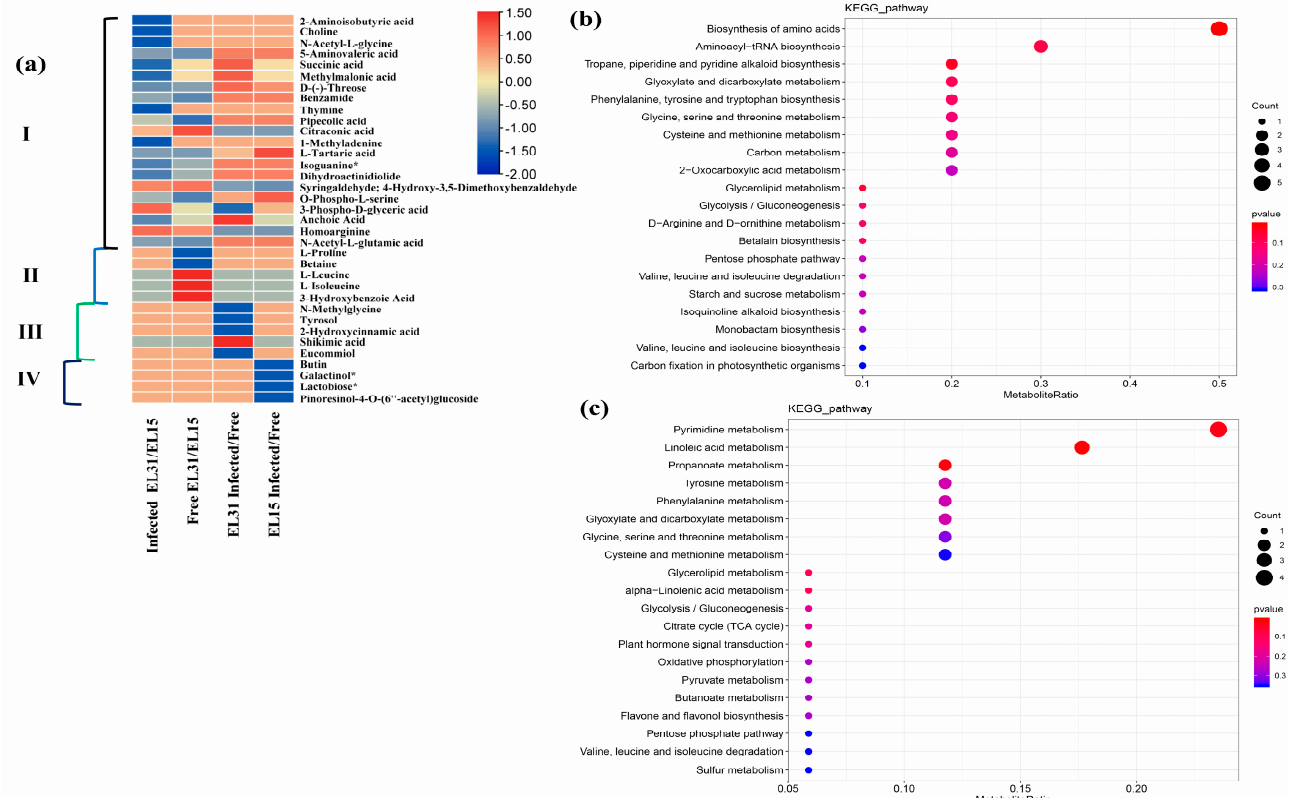
Figure 7. PCA, heatmap, and correlation analysis of metabolites in berries. ( a ) Clustering heat map of all metabolites. Red represents up − regulation, and blue represents down − regulation; ( b ) Pearson correlation coefficients of the six berry samples.